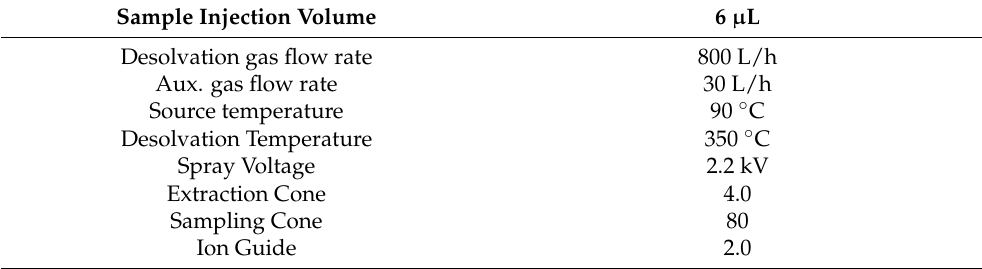
Table 5. Machine settings employed for the Waters Q-ToF mass